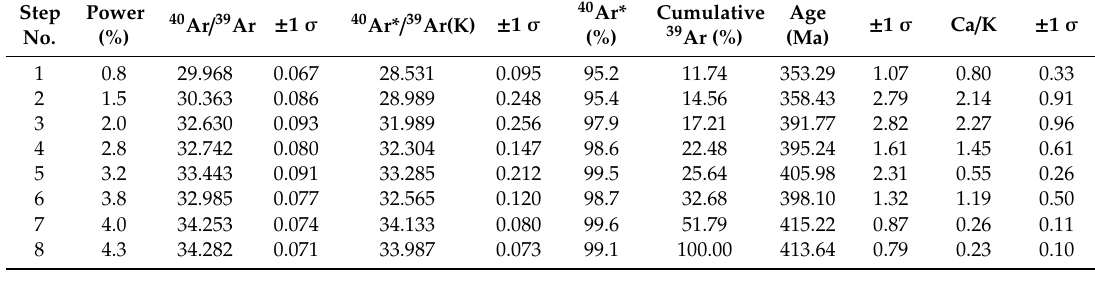
Table 10. Argon step heating data of muscovite separate from sample LG-85-3, J value = 0.007563 ±